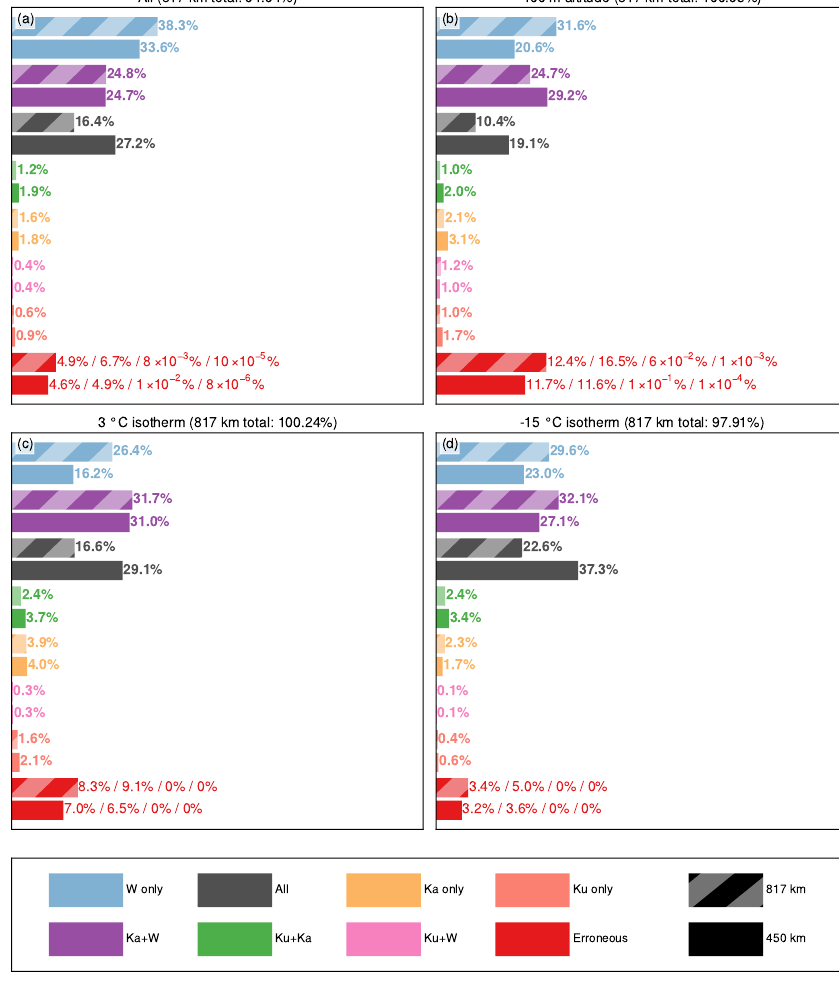
From a radar perspective, this region is characterized by both heavy attenuation and significant NUBF. As shown in Fig. 6, the W-band signal is sufficiently attenuated in many places as to be undetectable in the bottom 4–5 km of the ver- tical